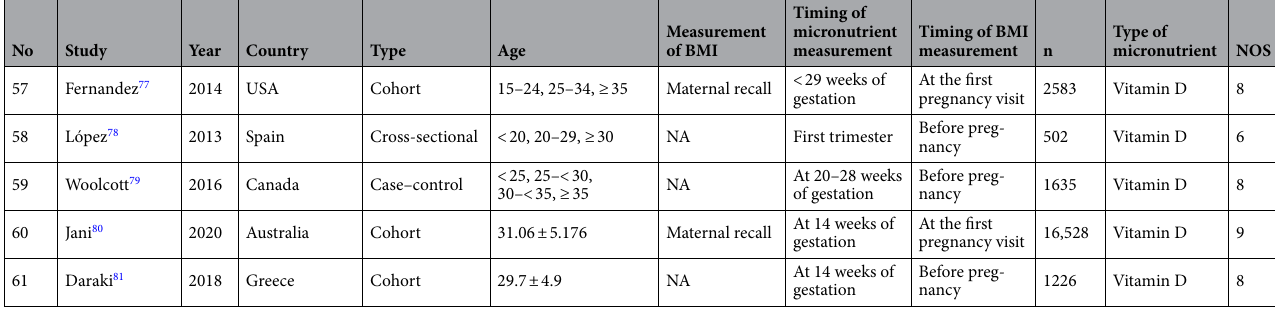
Table 1. Characteristics of the included studies. NA data not available, NOS Newcastle–Ottawa Scale.